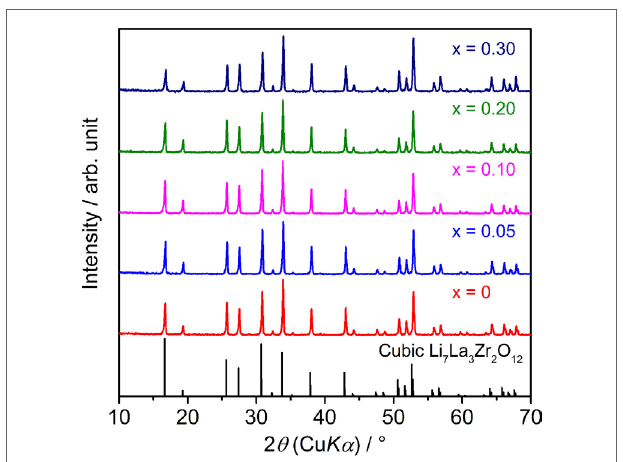
FigUre 1 | XrD patterns for sintered llBZT with different Ba contents x